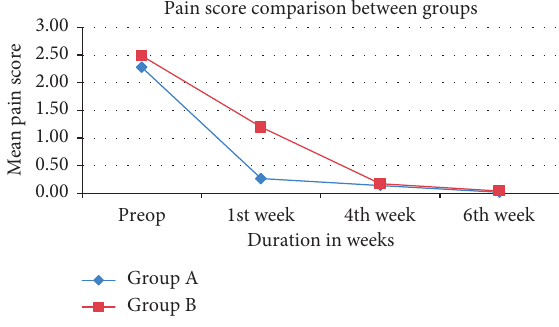
Figure 1: Comparison of pain score between two groups. Table 7: Comparison of other symptoms excluding abdominal